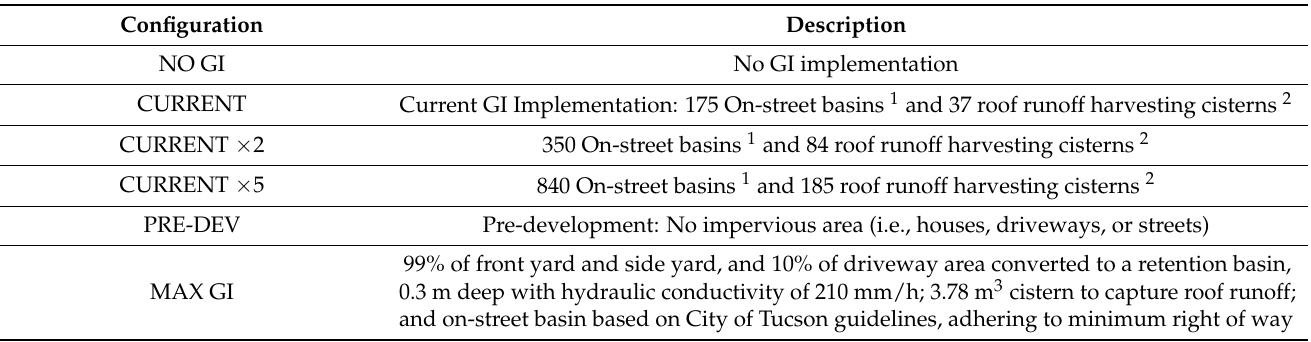
Table 2. Summary of KINEROS2 model configurations to simulate various GI implementation scenarios. Configuration